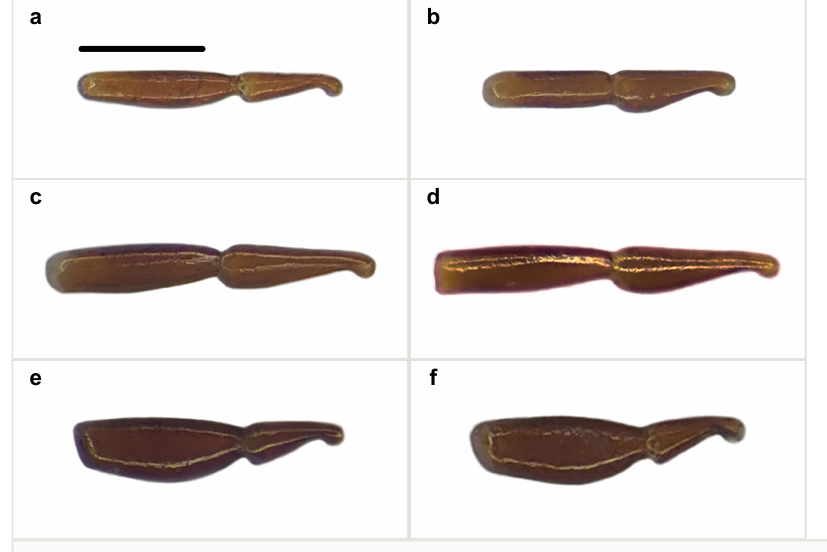
Figure 3. Maxillary palpi of Pareuryaptus spp. from China (scale bar = 0.3 mm): a , P. adoxus (Tschitschérine), female from Damenglong, Yunnan; b , P. exiguus Dubault, Lassalle & Roux, male from Naqin Village, Guangxi; c , P. luangphabangensis Kirschenhofer, female from Nanpaxiaozhai, Yunnan; d , P. luangphabangensis Kirschenhofer, male from Jino Mt., Yunnan; e , P. chalceolus chalceolus (Bates), male from Guanyin Mt., Guangdong; f , P. chalceolus formosanus (Jedli č ka), female from Jialeshui, Body length = 12.2–12.6 mm. Dorsal surface largely black. Terminal maxillary palpimere cylindrical, of similar width as distal end of penultimate one, distinctly longer than penultimate one. Pronotum faintly blue, transversal round (pronotum width / pronotum length = 1.40–1.42), widest a little behind anterior third; pronotum densely and coarsely punctate between basal foveae; lateral margins hardly sinuate in front of posterior angles; posterior angles rounded and obtuse.